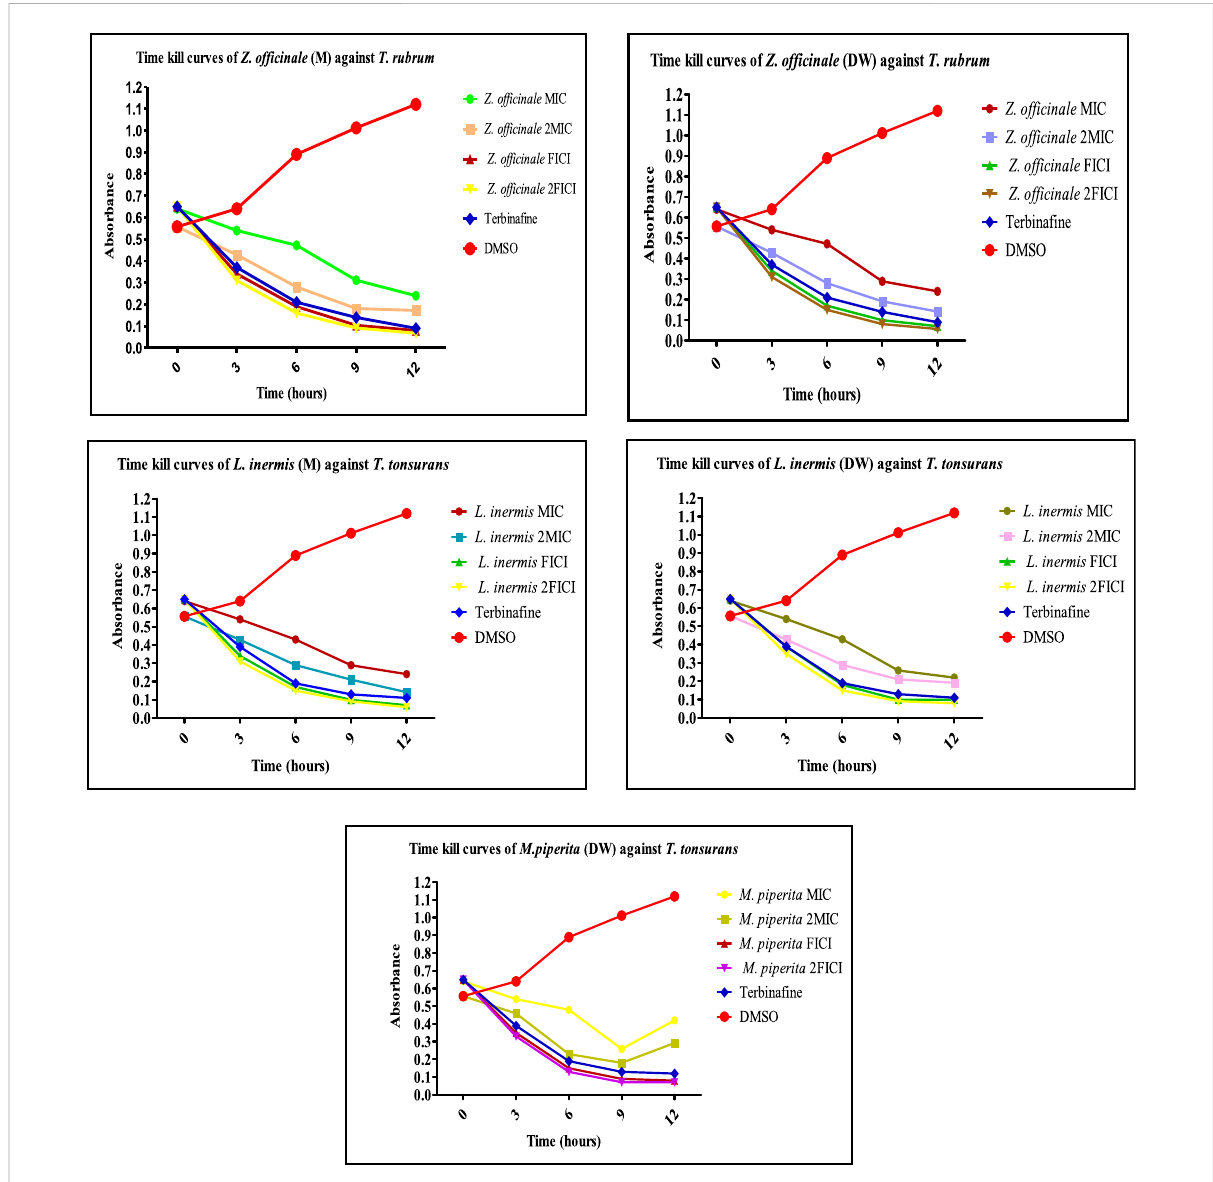
FIGURE 7 Time-kill curves of selected extracts against dermatophytes. M, methanolic extract; DW, distilled water extract.